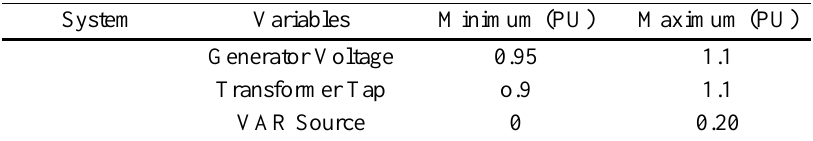
Table 4. Constraints of control